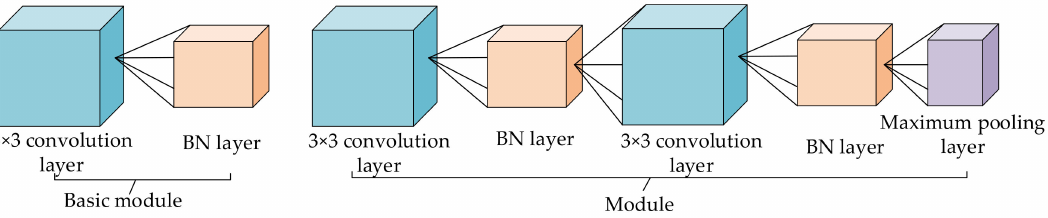
Figure 2. The structure of the proposed